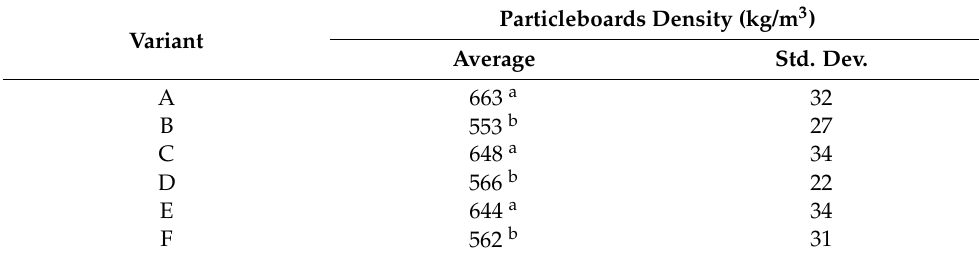
Table 2. Average density of manufactured